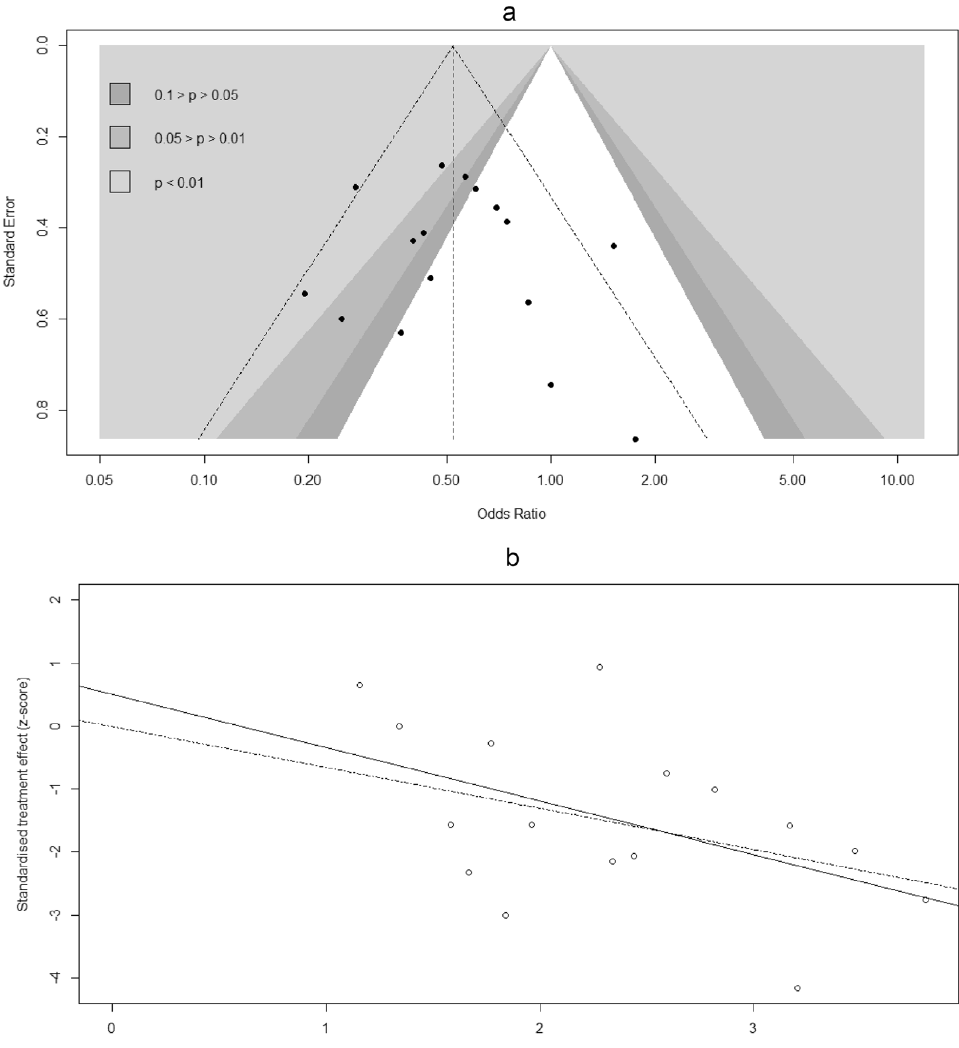
Fig. 7 a: Funnel plot under the fixed effects model, with contours for the different levels of statistical significance, for the included sample of studies, demonstrating the absence of substantial publication bias due to adequate symmetry around the overall estimate of the peto OR. b: Radial plot under the fixed effects model, demonstrating the absence of significant deviation of our studies’ regression line (dashed line through the origin) from the included regression line for the Egger’s test (solid